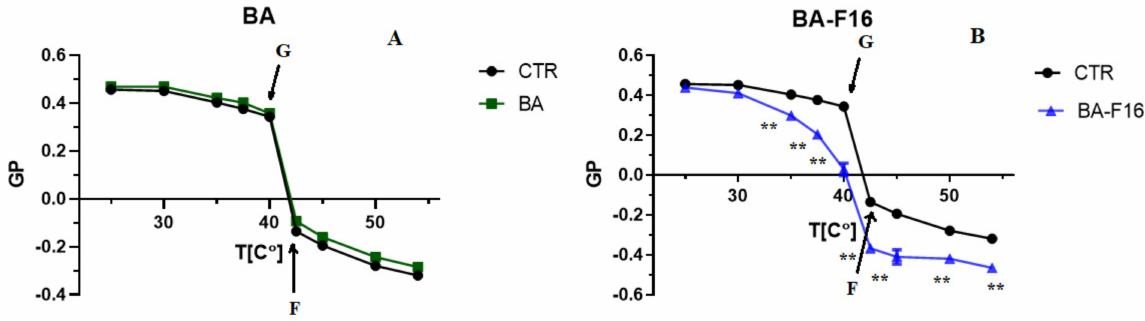
Figure 7. Effect of 10 µ M of BA ( A ) and 2 µ M of BA–F16 ( B ) on the phase state of DPPC liposomes. The transition from a solid- (G—gel state) to a liquid-crystalline state (F—fluid state) is defined as the point of maximum curvature. The incubation medium contained: 10 mM Tris-HCl (pH 7.5), 40 mM KCl, and 50 µ M EGTA. Temperature measurements range from 25 to 54 ◦ C. CTR—without additions. The results are presented as means ± SEM ( n = 3). ** indicates p < 0.01 when compared with control